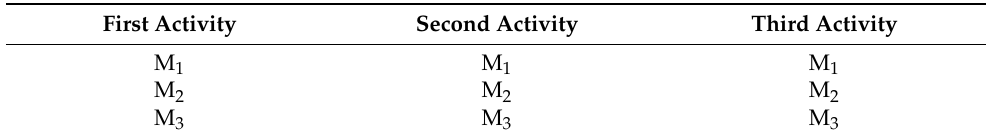
Table 2. Possible number of maintenance activities in